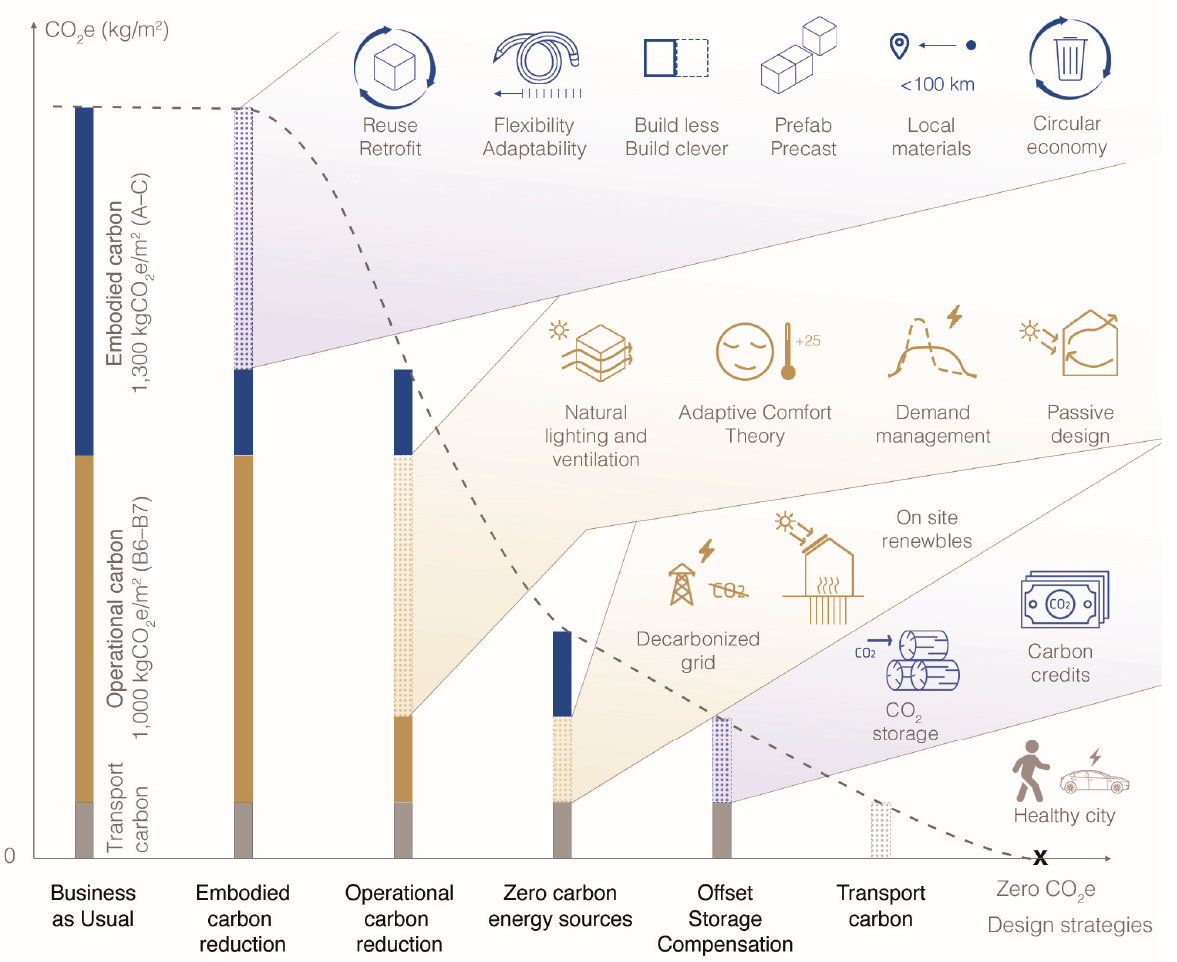
Figure 3. Embodied and operational carbon timeline to complete decarbonization in four phases. Starting from the business-as-usual (BaU) condition, it is possible to reduce embodied and operational carbon and then offset/compensate for the remaining part. Transport carbon can be considerably reduced by applying healthy-city principles.